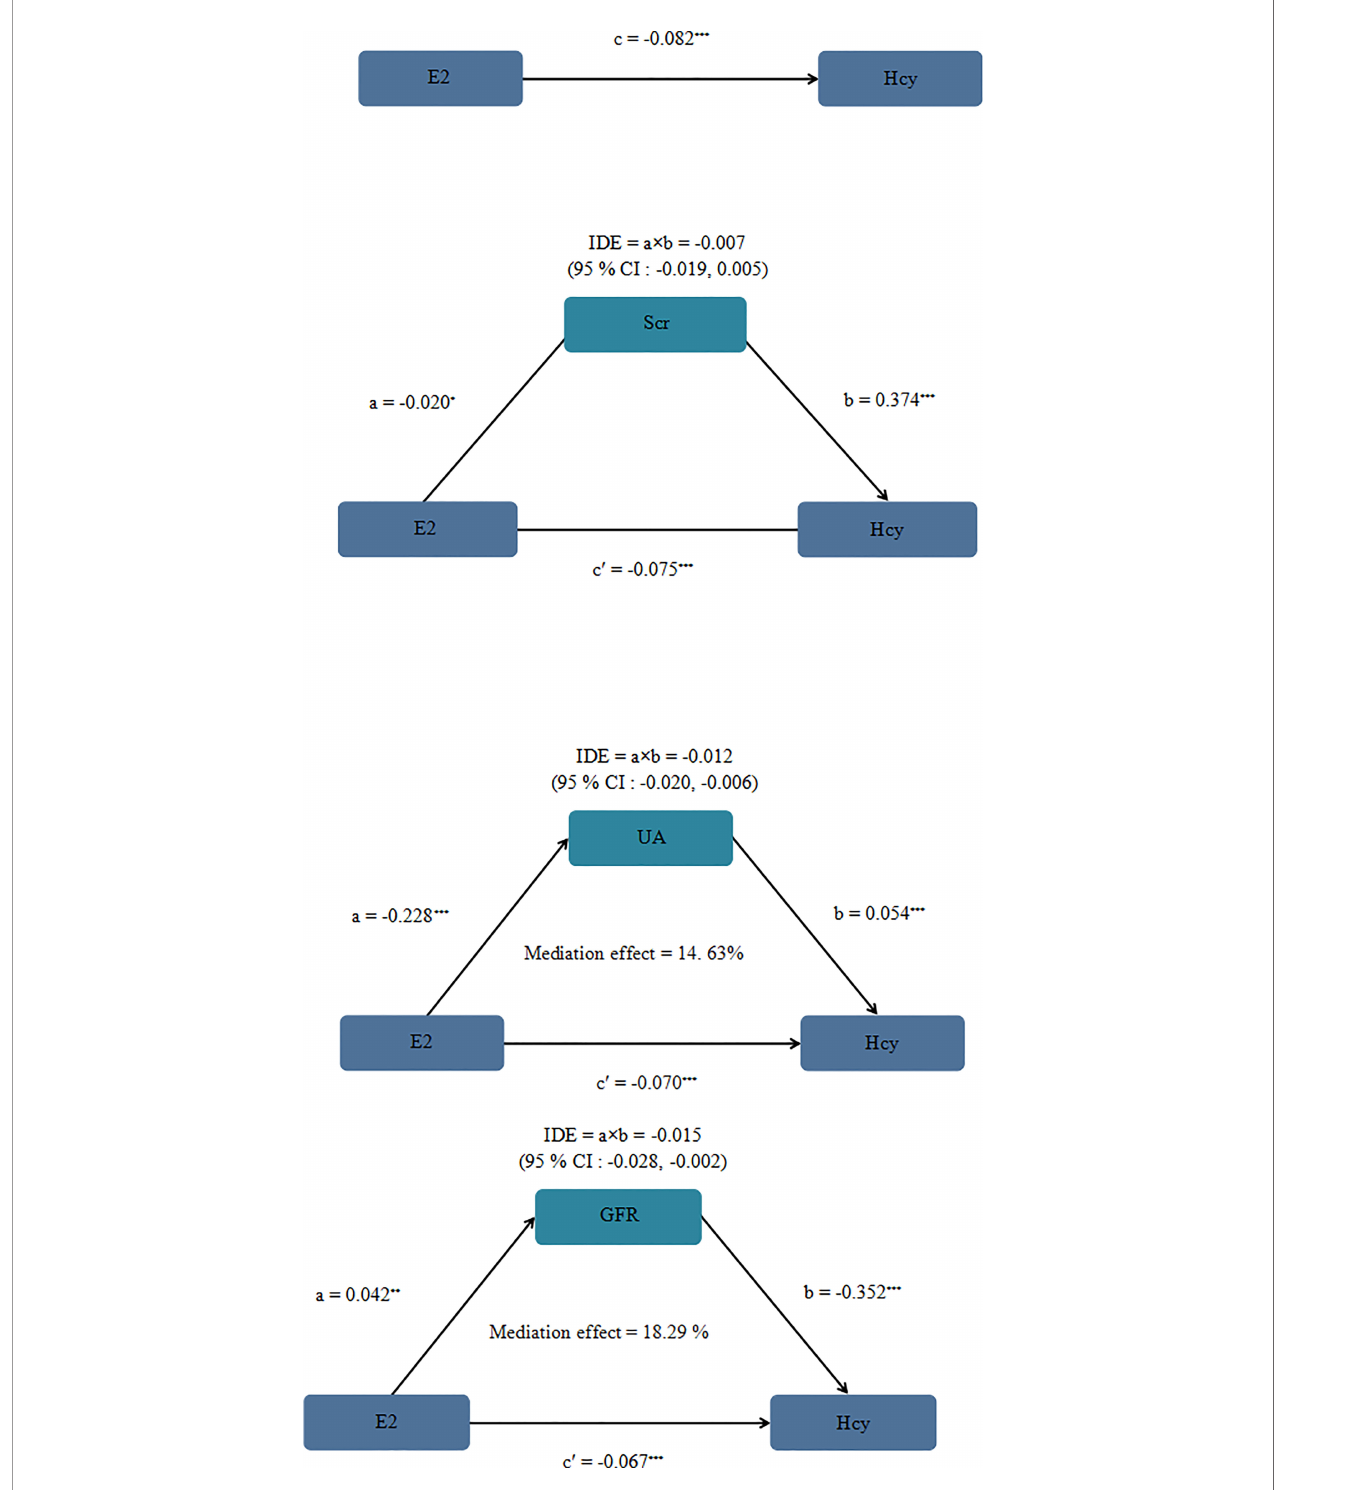
FIGURE 2 | Mediation analysis model of female Scr, UA and GFR on the E2 - Hcy association after adjusting for covariates. Note: a, b, c and c' are standardized regression coef fi cients; a, indirect effect l; b, indirect effect 2; c, total effect; c', direct effect, IDE total indirect effect, If the 95% CI of the indirect effect includes 0, there is no mediating effect. We adjusted BMI, drinking history, smoking history, living area, menopause, education. At the same time, in the mediating effect model, we transformed Scr, UA, GFR, E2 and Hcy into natural logarithm, *P = 0.218 **P = 0.017 ***< 0.001.